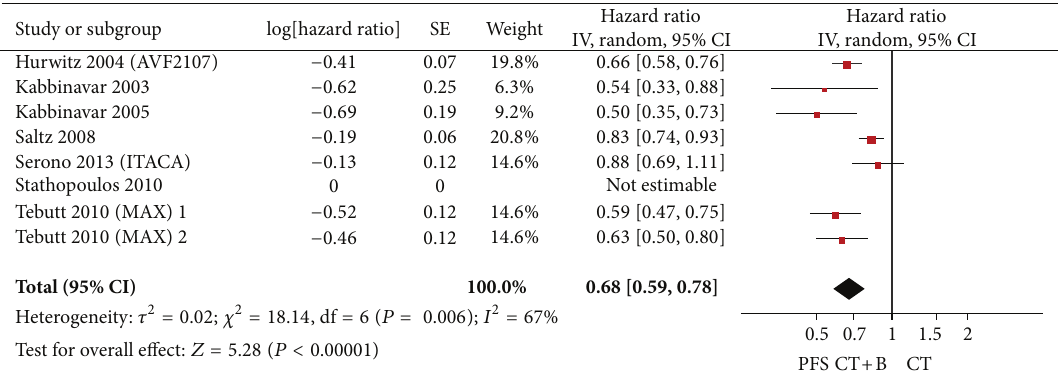
Figure 4: Randomized effect model on HR of PFS in first-line chemotherapy. The beneficial HR of PFS in standard first-line chemotherapy is symbolized by a solid diamond at the bottom of the forest plot and the width of which represents the 95% CI.